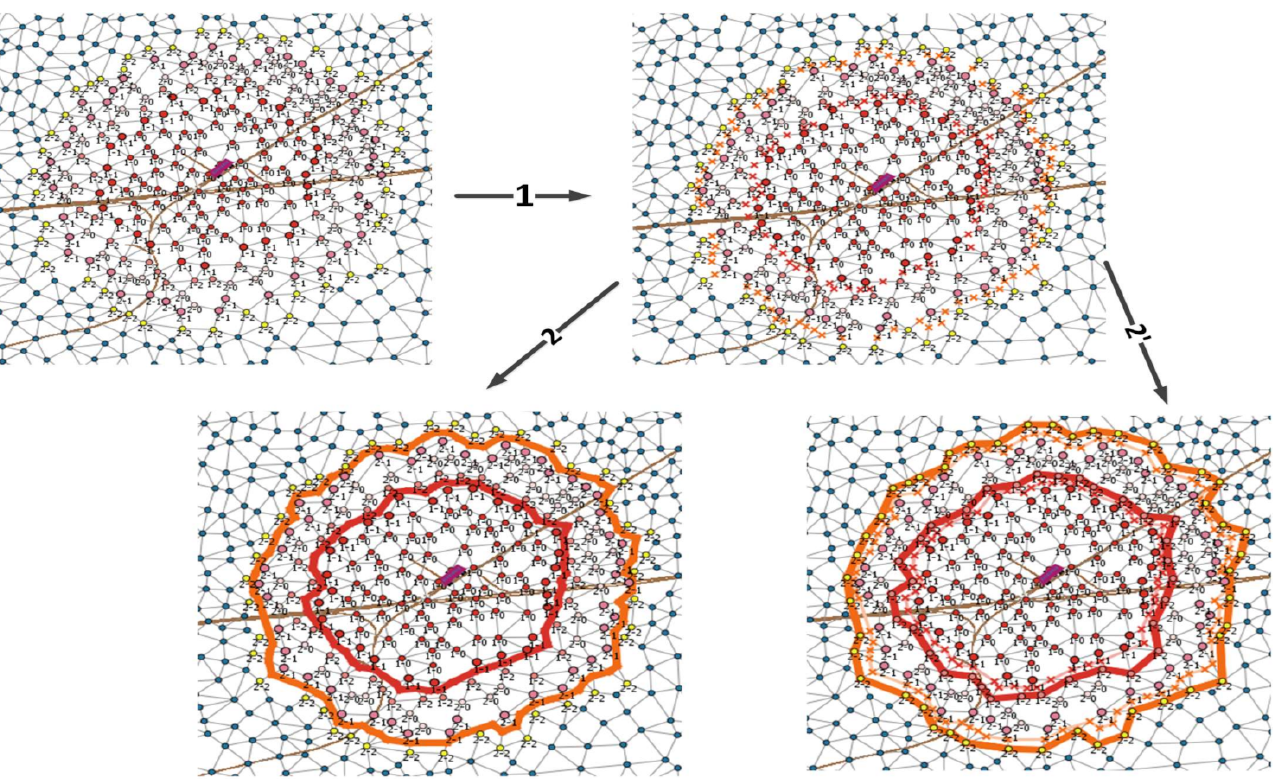
Figure 12. Building a vague spatial object from distributed noise measurements. (1) Inferring vertices from a weighted approximation. (2) Building boundaries using a weighted approximation. (2 (cid:48) ) Upper approximation of noise polluted areas during a short